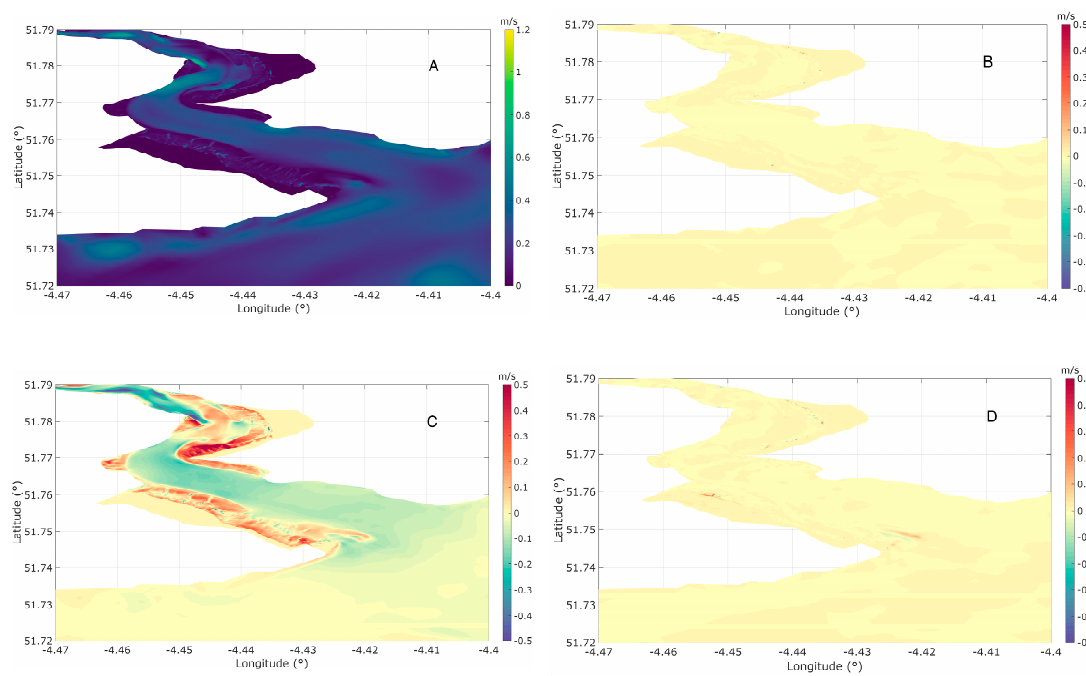
Figure 17. Comparison of peak flood current magnitude during the 1:50 year easterly storm. ( a ) Current condition, ( b ) difference between defended and current condition, ( c ) difference between grazed and current condition, and ( d ) difference between managed realignment and current condition.